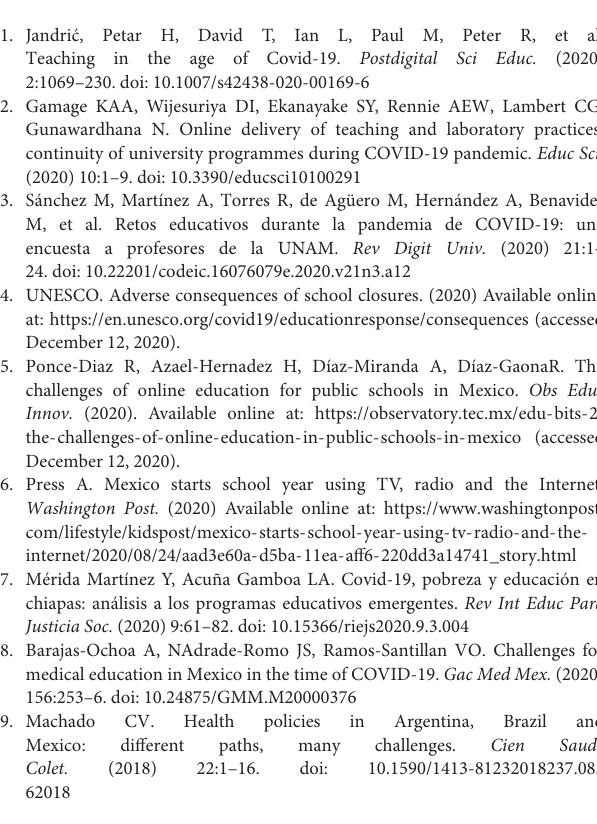
Supplementary Table 11 | Statistical Correlations for FOBAP vs. Adapted COVID STRESS